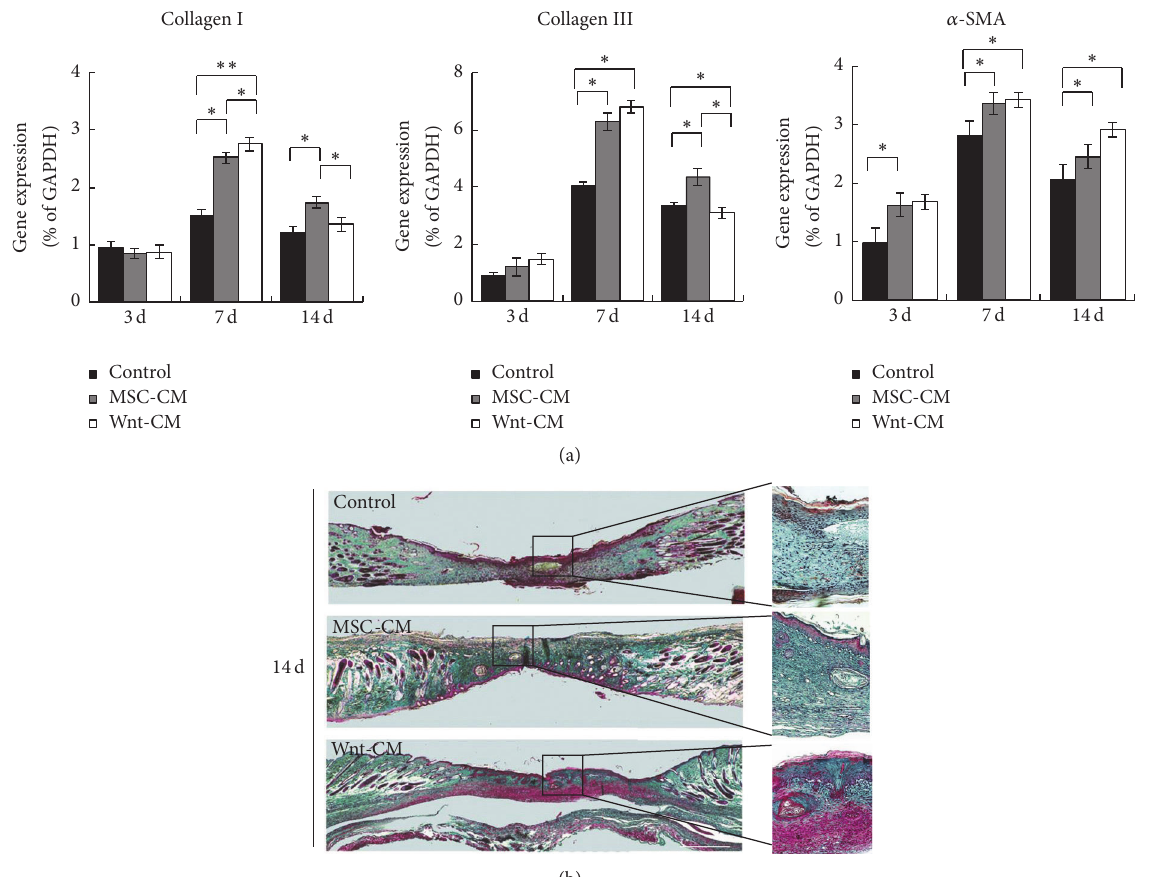
Figure 3: Expression of ECM components during the wound healing process in mice. (a) Expression levels of 𝛼 -SMA, collagen III, and collagen I mRNA in mice of treatment groups DMEM, MSC-CM, and Wnt-CM were analyzed by real-time PCR and normalized to that of GAPDH. (b) Representative images of skin biopsy samples (obtained from mice of treatment groups DMEM, MSC-CM, and Wnt-CM), showing staining with Masson’s trichrome. Statistical analysis involved unpaired t tests. The data are presented as mean ± SEM, 𝑛 = 3 ; ∗ 𝑃 < 0.05 and ∗∗ 𝑃 < 0.01 . The scale bar is 200 𝜇 m in panel